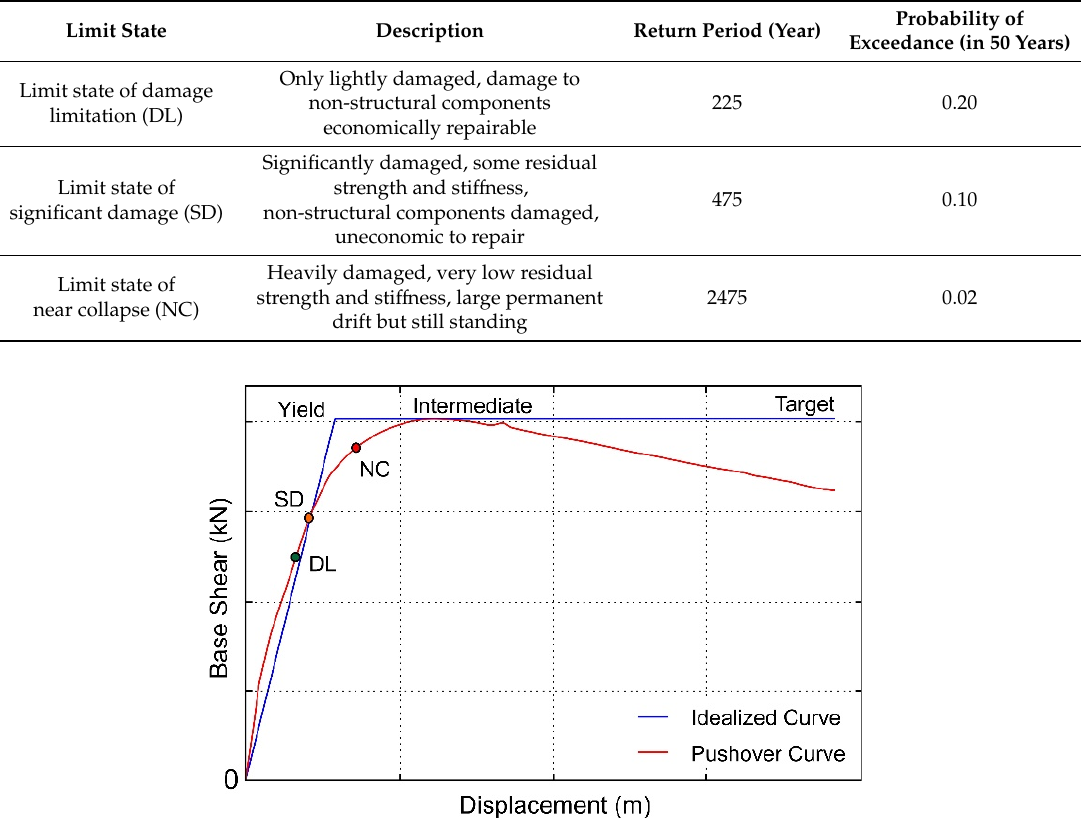
Figure 13. Comparison of pushover curves for 6-story. Table 8. Comparison of values obtained in X direction for 3-story building. Province